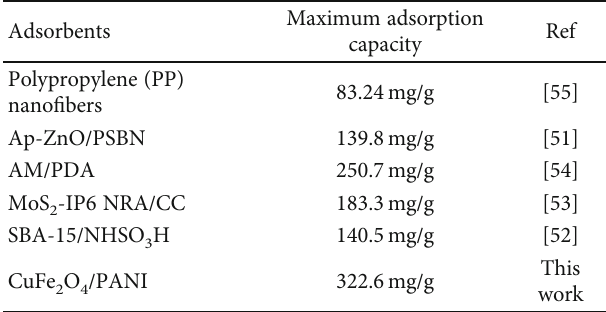
Table 4: Comparison of adsorption capacity of CuFe nanocomposite with di ff erent adsorbents.